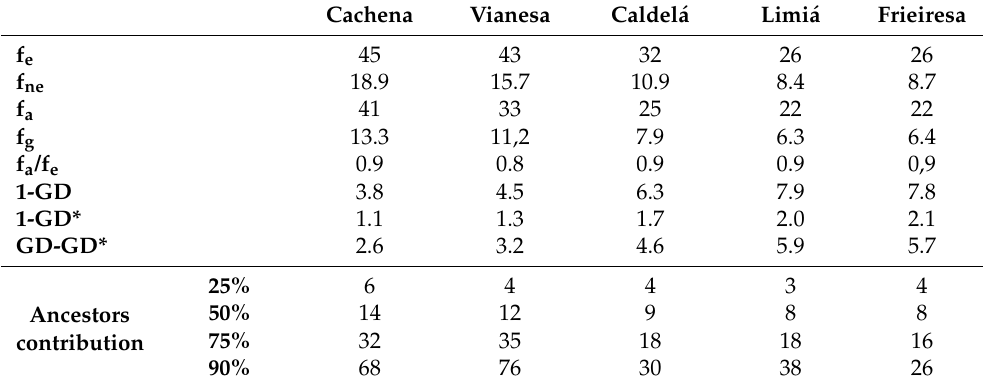
Table 4. Probability of gene origin parameters and ancestor contribution of the five Galician bovine breeds.